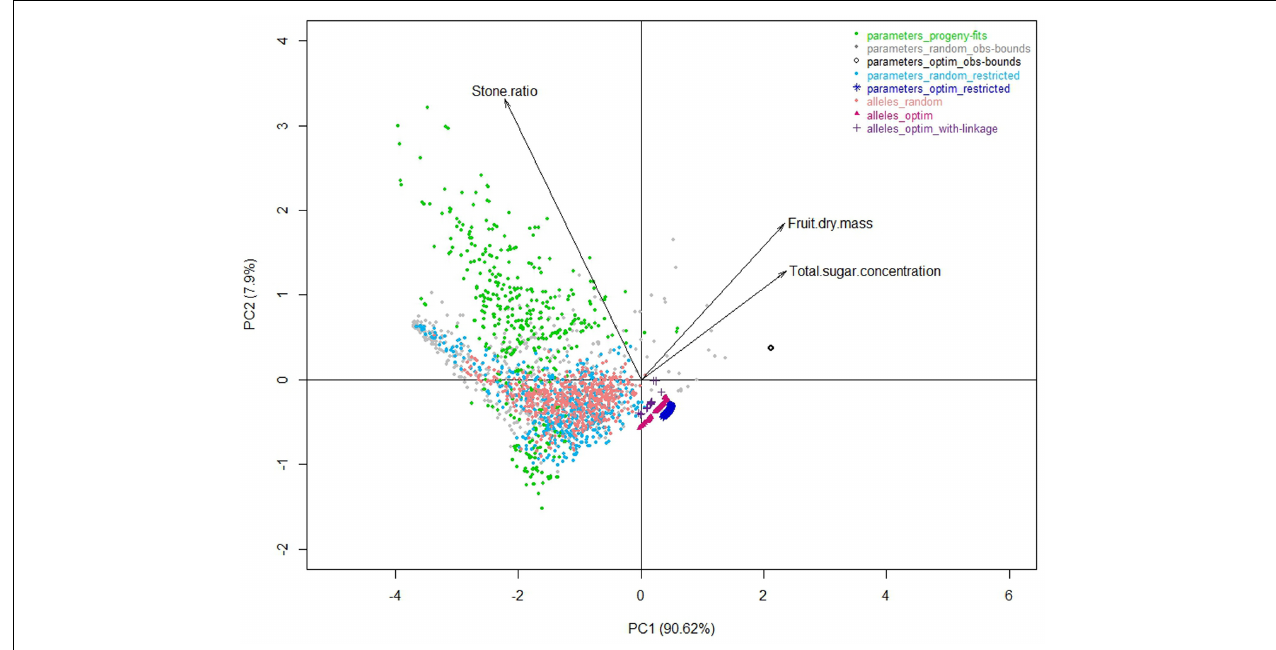
FIGURE 5 | Correlation plots of the three target traits for the first two principal components of a PCA analysis performed on the whole of the eight datasets.